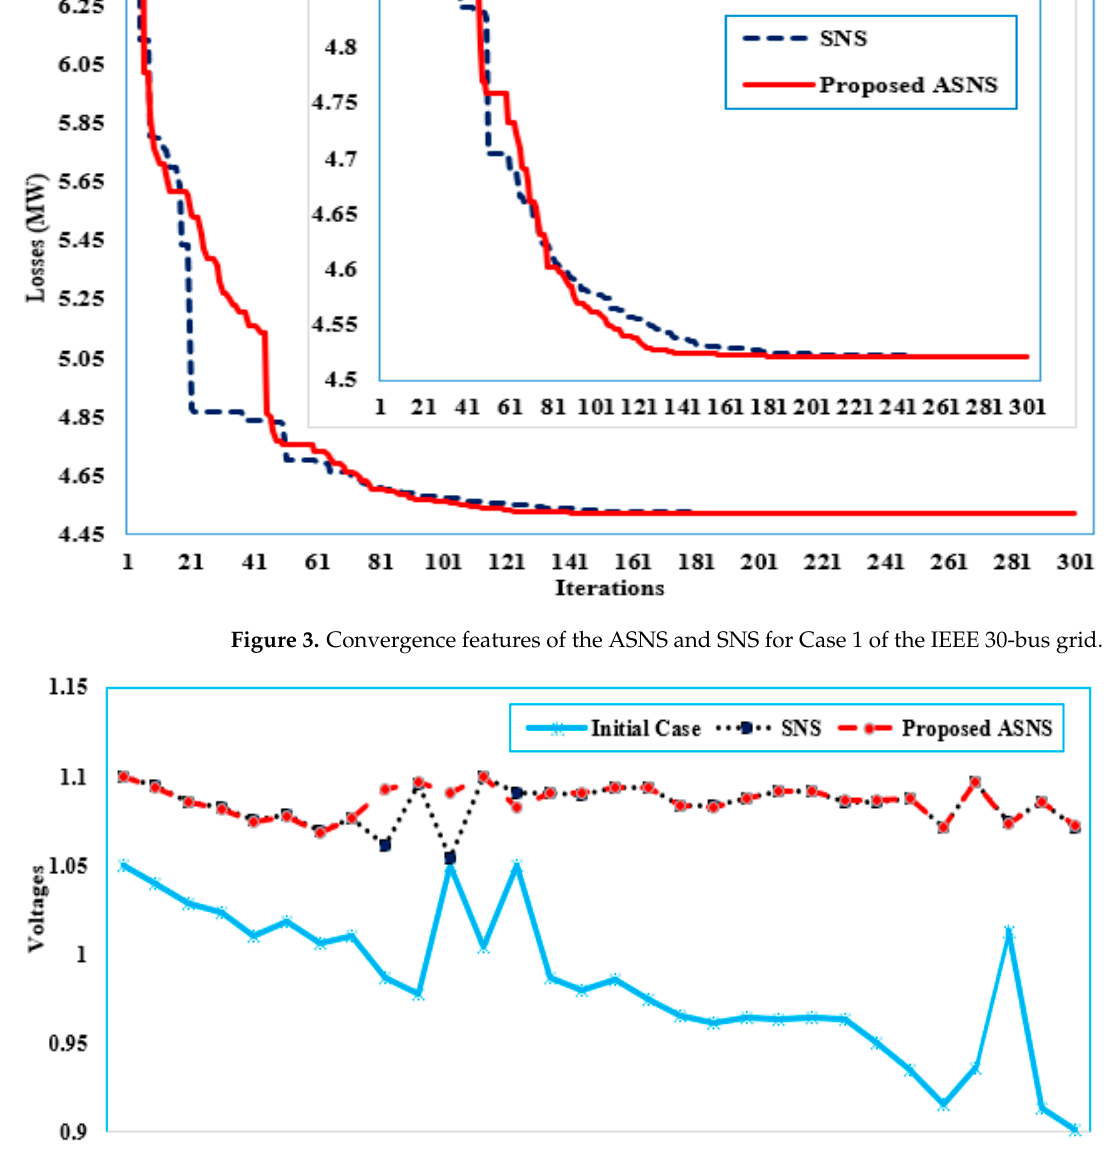
Figure 4. Voltage Pro fi le of the proposed ASNS and SNS for Case 1 of the IEEE 30-bus grid. Table 2. Optimal results for Case 1 of the IEEE 30-bus grid.